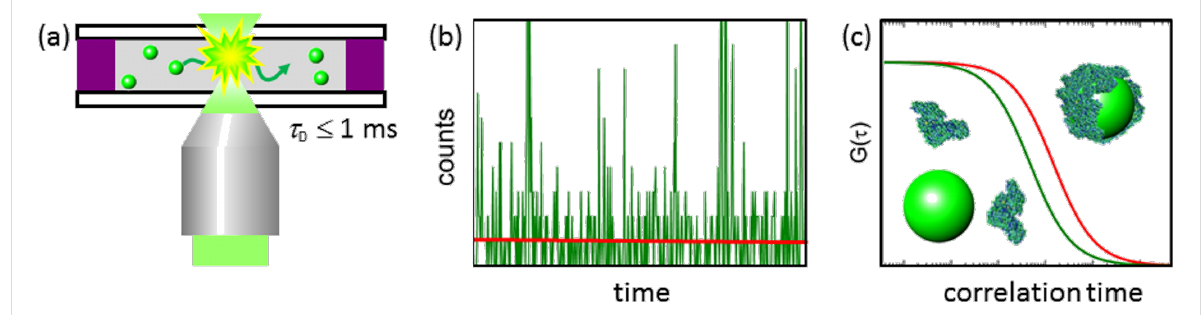
Figure 1: Principle of fluorescence correlation spectroscopy. (a) Individual fluorophores diffusing through the observation volume emit brief bursts of photons. (b) Fluorescence intensity time trace. (c) Fluorescence intensity autocorrelation function. Its amplitude at time 0 scales with the inverse NP concentration; the characteristic decay time, τ D , scales with the hydrodynamic radius, R H , of the diffusing